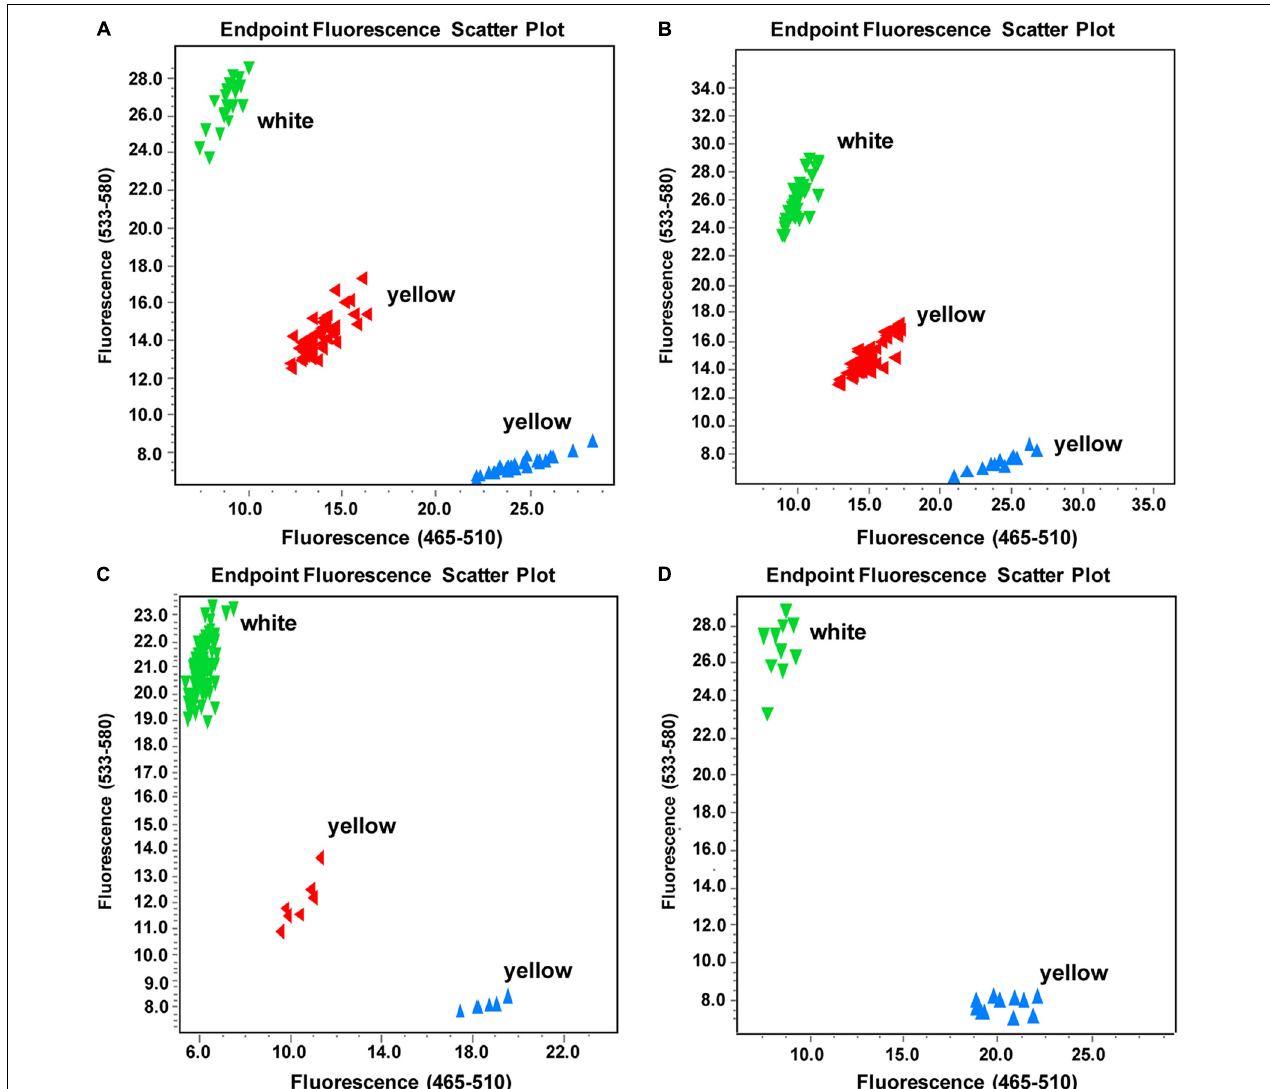
FIGURE 6 | Genotyping results of marker TXBH83 in part individuals of different populations. (A–D) Genotyping results of TXBH83 in the (Y640-288 × Chiifu)-F 2 , (Y640-288 × SD369)-F 2 , and (Y66-83 × R16-11)-F 2 populations and a natural population, respectively. More white-flowered plants were intentionally selected. The genotypes corresponding to those of Y640-288 are clustered to the Y axis, those matching Y641-87 genotypes are clustered to the X axis, and the heterozygous genotypes are clustered to the diagonal line. TXBH83 is totally co-segregated with the flower color